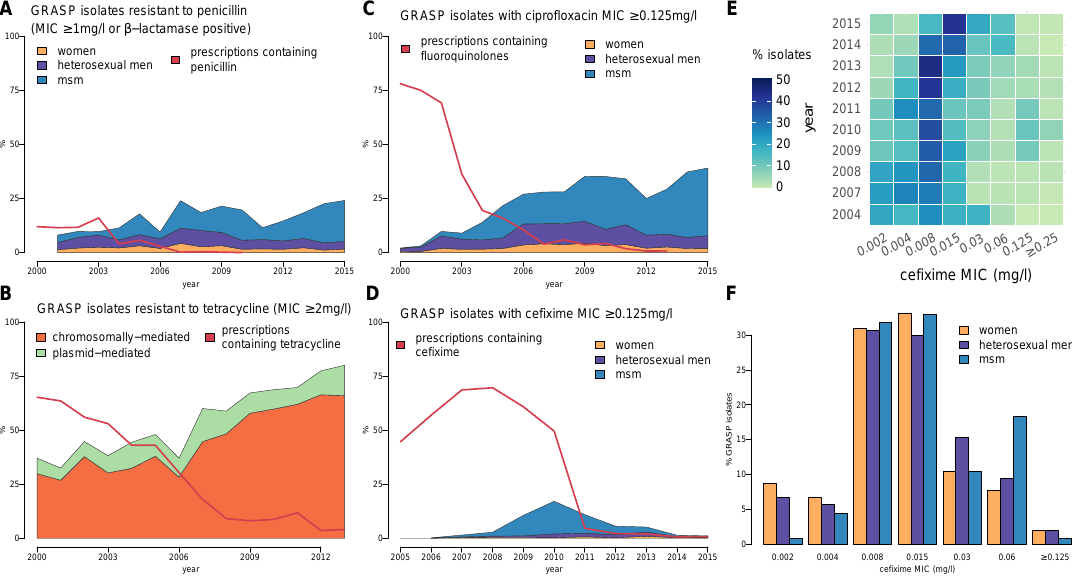
Figure 4. Proportion of gonococcal isolates in GRASP over time showing ( A ) resistance to penicillin, split by gender and male sexual behaviour, compared with the proportion of prescriptions containing penicillin; ( B ) chromosomally- vs. plasmid-mediated tetracycline resistance, compared with the proportion of prescriptions containing a tetracycline; ( C ) resistance to ciprofloxacin by gender and male sexual behaviour, compared with the proportion of prescriptions containing a fluoroquinolone, such as ciprofloxacin or ofloxacin; ( D ) resistance to cefixime by gender and male sexual behaviour; ( E ) cefixime MIC distribution over time and ( F ) cefixime MIC distribution in 2014 split by gender and male sexual